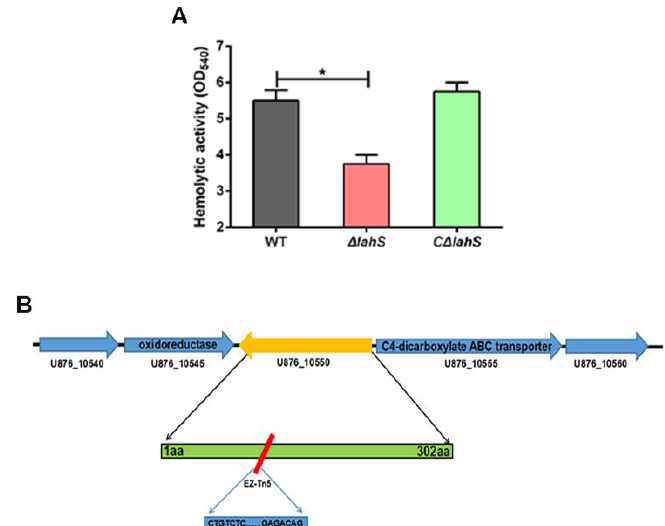
Figure 3. The lahS gene was involved in hemolytic activity of A. hydrophila. ( A ) Hemolytic activity of the wild-type and lahS mutant strains. A. hydrophila strains were grown overnight in Luria Bertani broth (LB) medium at 28 ◦ C, after which 100 µ L of supernatants were added to 1% sheep blood for 1 h at 37 ◦ C. Hemolytic activity was expressed as the values measured at OD 540 . * p < 0.05. ( B ) Schematic diagram of the EZ-Tn5 transposon insertion in the lahS gene. The gene cluster shows the location of the lahS gene in the NJ-35 genome. The red rectangle shows the transposon insertion site in lahS .